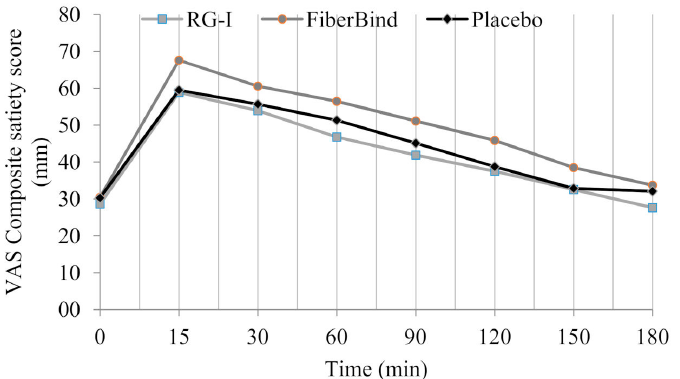
Figure 3. Mean ± standard error of mean (SEM) three-h repeated ratings of subjective appetite sensations presented as a composite satiety score (RG-I: n = 18, FiberBind: n = 17, control: n = 18). The composite satiety scorewas higher after FiberBind compared to RG-I (6% ± 2%, p < 0.05) and control (5% ± 2%, p < 0.05). Abbreviations: mm, millimeter; RG-I, rhamnogalacturonan I; VAS, visual analog